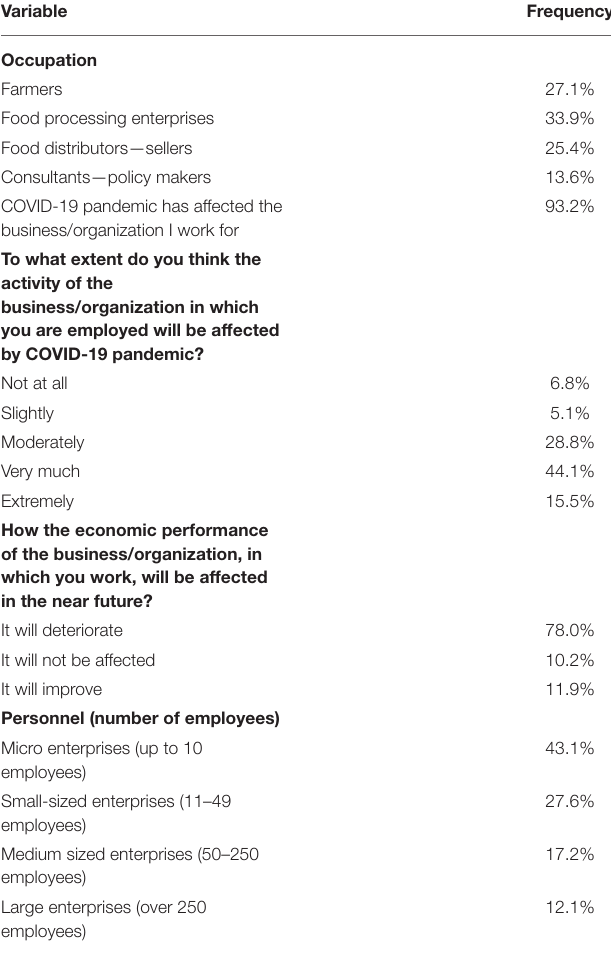
TABLE 1 | Experts’ profile ( N =